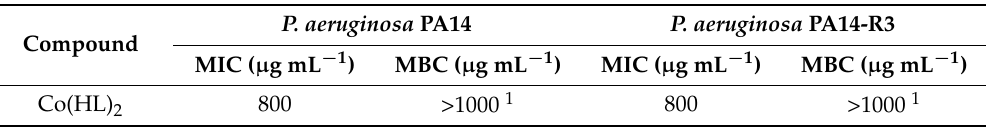
1 MBC not found, it is higher than the maximum concentration tested (1000 µ g mL − 1 ).